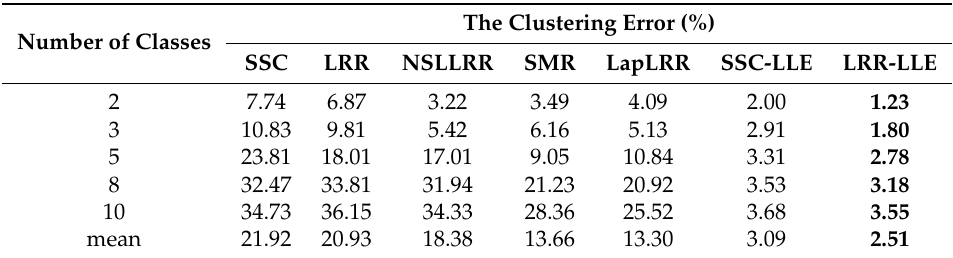
Table 3. Clustering results on Extended Yale dataset B. The clustering errors for 2, 3, 5, 8, 10 classes and their mean error are shown here. The best results are in bold font.